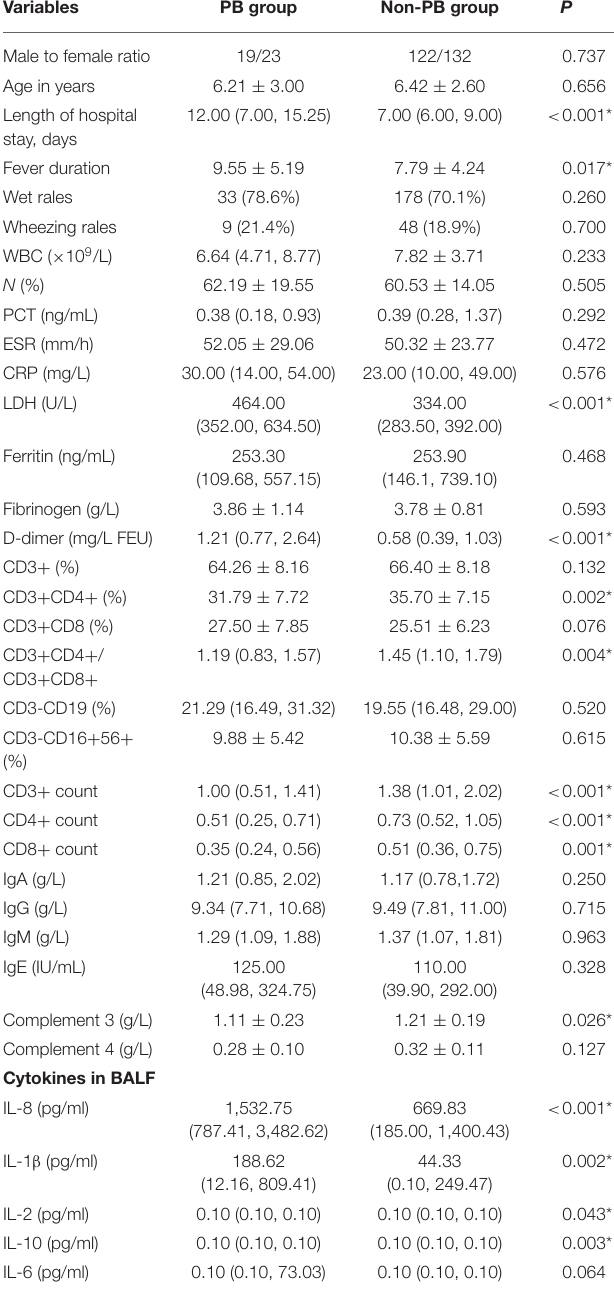
TABLE 1 | Clinical features and laboratory values between the PB group and the non-PB group in children with MPP.